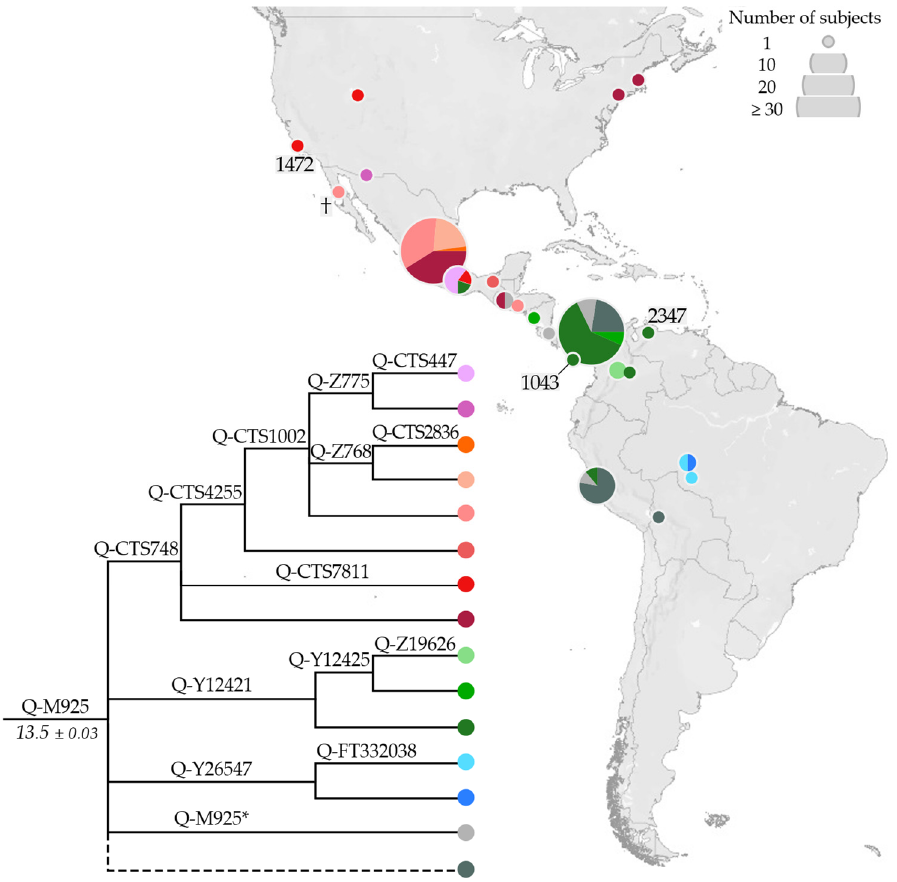
Figure 5. Geographical distribution of Q-M925 (ISOGG nomenclature: Q1b1a1a1e—http://www.isogg.org/tree/, accessed on 19 January 2022) and its main sub-lineages. Ancient individuals are indicated with their median calibrated age (cal BP, see Table S1 for details), or with a cross when the age was not available. The dashed line indicates Q-M925 samples less well defined (missing positions of informative downstream markers). In the phylogeny, the estimated age of the node (±StDev) is reported in kya.